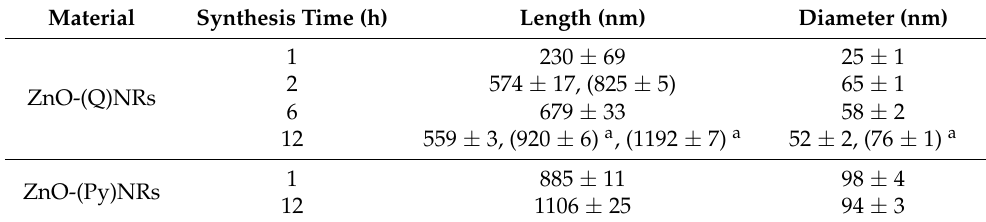
Figure 1. SEM images of ZnO-(Q)NRs synthesized for ( a ) 1, ( b ) 2, ( c ) 6, and ( d ) 12 h. Table 1. Dimensions of the ZnO-(Q)NRs in Figure 1 and ZnO-(Py)NRs in Figure 2.